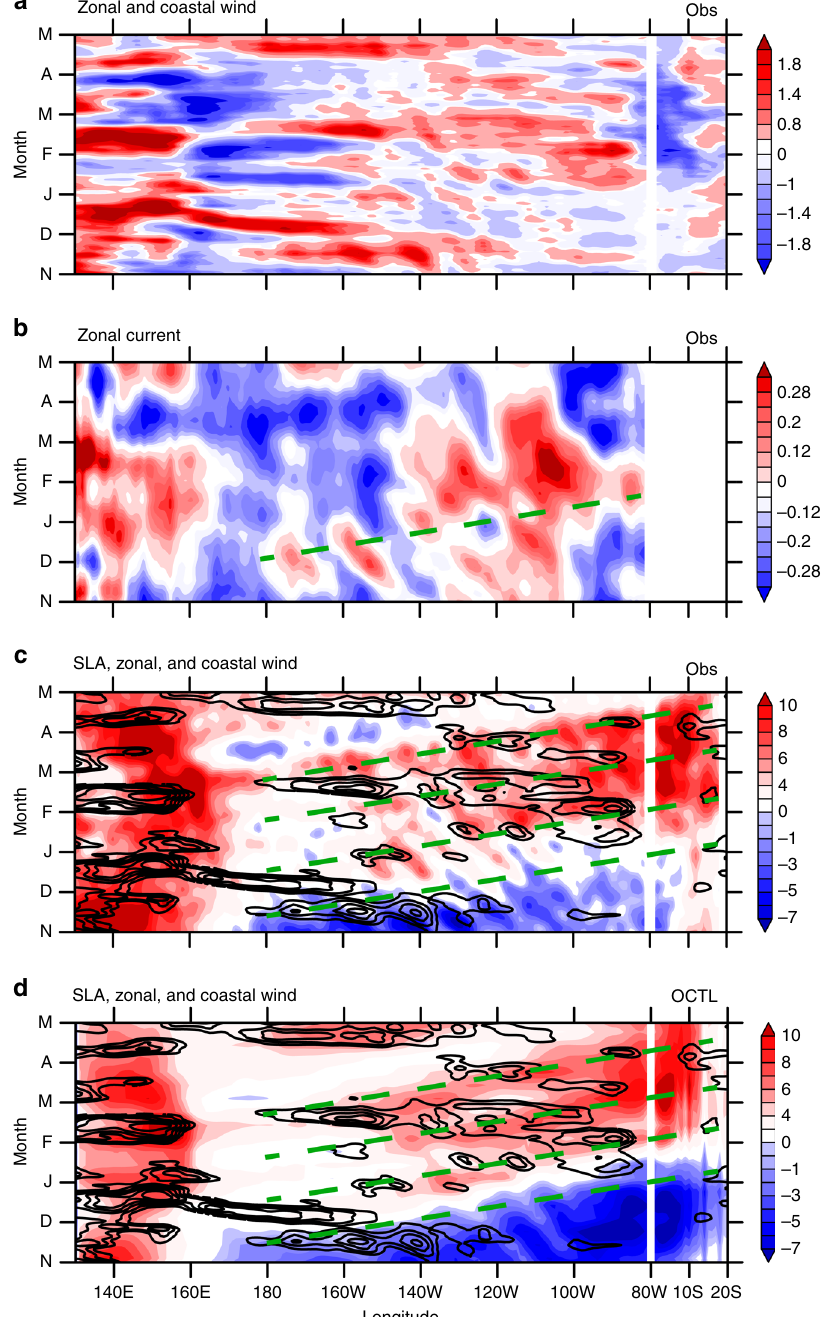
Fig. 4 Longitude – time evolution of the 2017 extreme coastal El Niño. Hovmöller diagrams for: a zonal and coastal wind anomalies (color shading; m s − 1 ; negative values along the coast of South America indicates northerly wind anomalies); b zonal current (color shading; m s − 1 ), green dashed line indicates Kelvin wave propagation; c SLA (color shading; cm) and zonal wind anomalies (contours with an interval of 0.5 m s − 1 ; positive solid and negative omitted) from observations; d same as c but from MITgcm OCTL. All meridionally averaged in 2 °S – 2 °N along the equator and zonally averaged in 80 °W – 85 °W along the